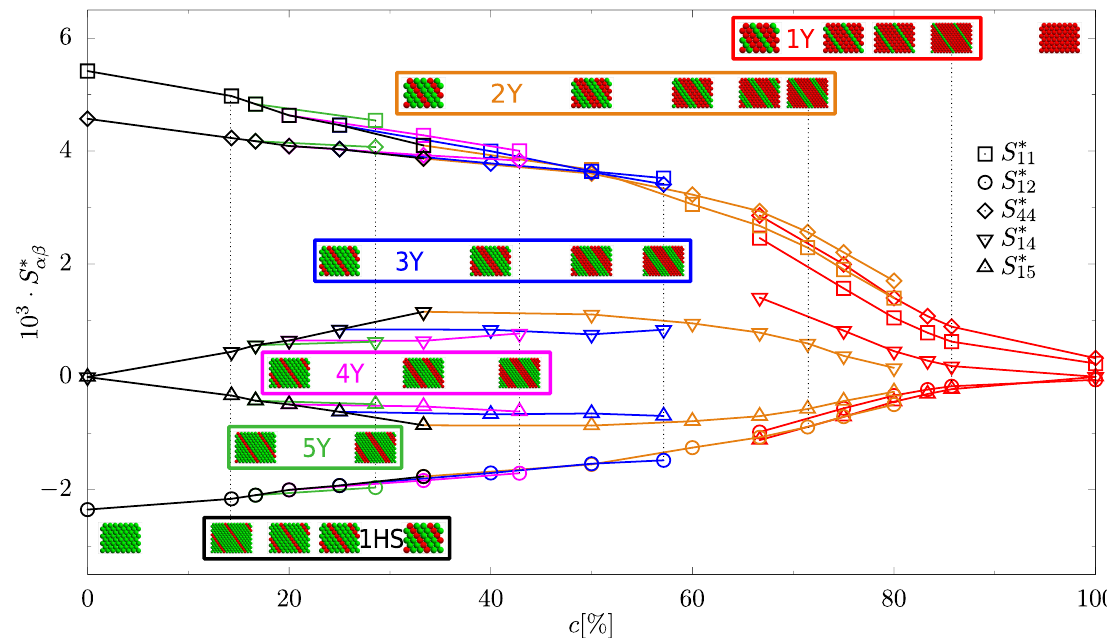
Figure 2. Elastic compliances versus concentration involved in particles of nanolayers in studied systems. Colors indicate the type of the system depending on the number of layers of appropriate particles in a nanolayer. 1HS (black) is the system with hard spheres monolayer. 1Y (red) is the system with monolayers of Yukawa particles. 2Y (light brown) is the system with double layers of Yukawa particles. 3Y (blue) is the system with triple layers of Yukawa particles. 4Y (magenta) is the system with four-layers of Yukawa particles. 5Y (green) is the system with five-layers of Yukawa particles. In addition, miniature images of studied systems are placed in the graph so that the centres of the structures coincided with the corresponding concentrations. The systems in the figure are grouped according to the numbers of layers in nanolayers. Miniatures of structures represent the studied systems seen from the [ ¯110 ] -direction. The color convention of data presentation from this figure is maintained in all following figures. Lines are drawn to guide the